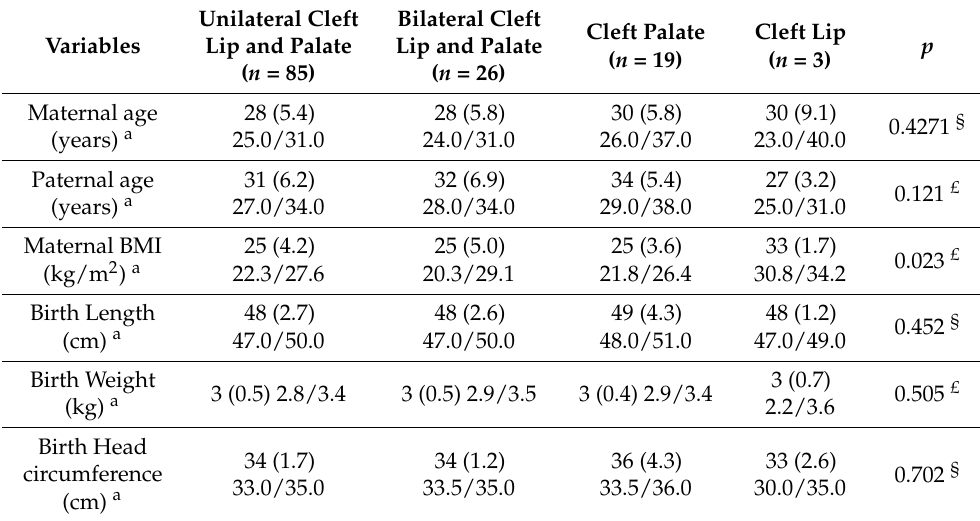
Table 3. Descriptive statistics concerning phenotype of cleft.